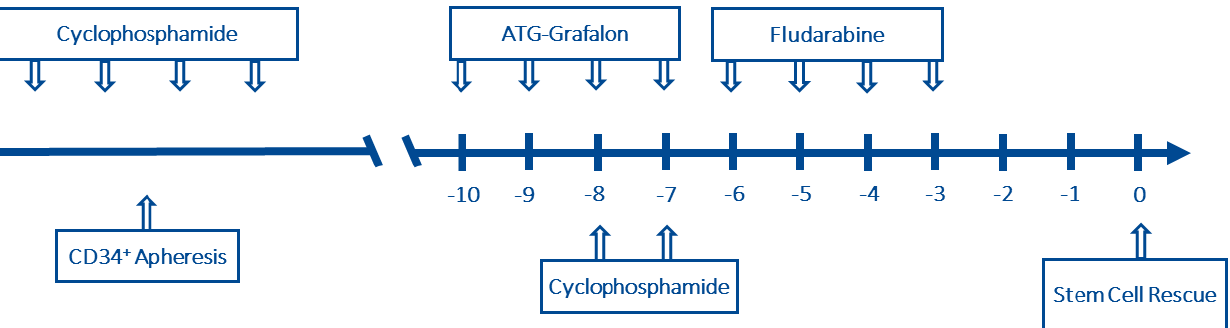
Figure 2. Immunoablative therapy (IAT) in both cases.